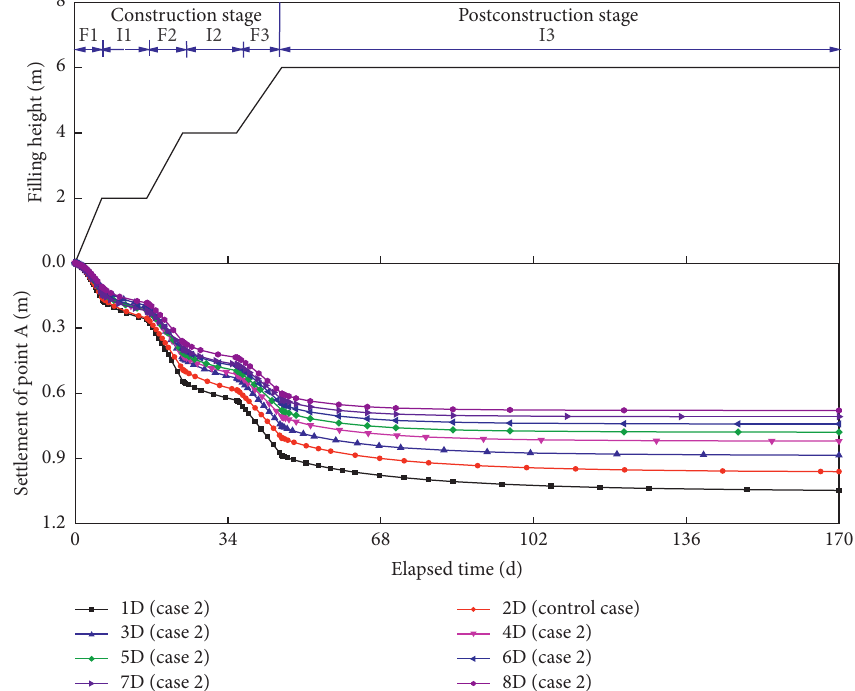
Figure 7: Influence of encasement length on the settlement of point